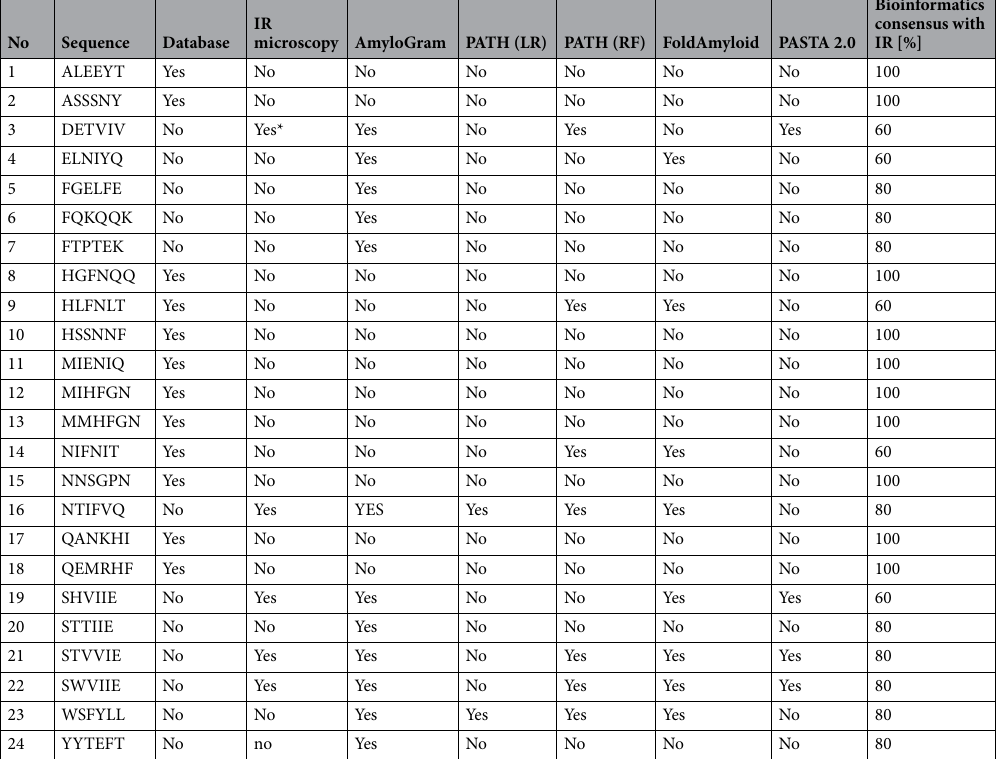
Table 4. Test sequences and their amyloid propensities predicted by different bioinformatics methods and compared with IR microscopy (’Yes’—amyloid, ’No’—non-amyloid, ’Yes*’—oligomer). For comparison, the ’ Database ’ column presents original annotations from the databases.